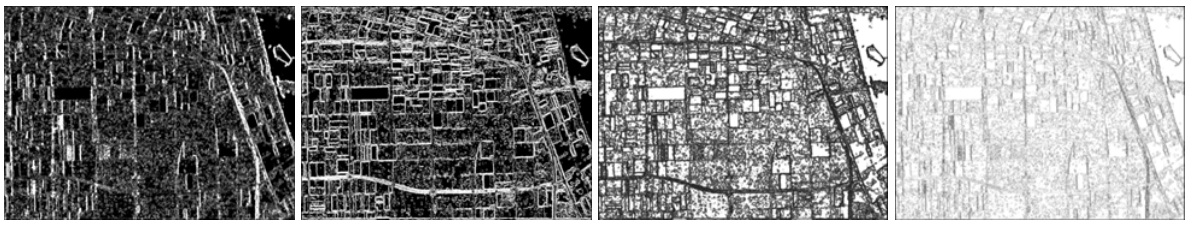
Figure 20. GLCM-based features of T